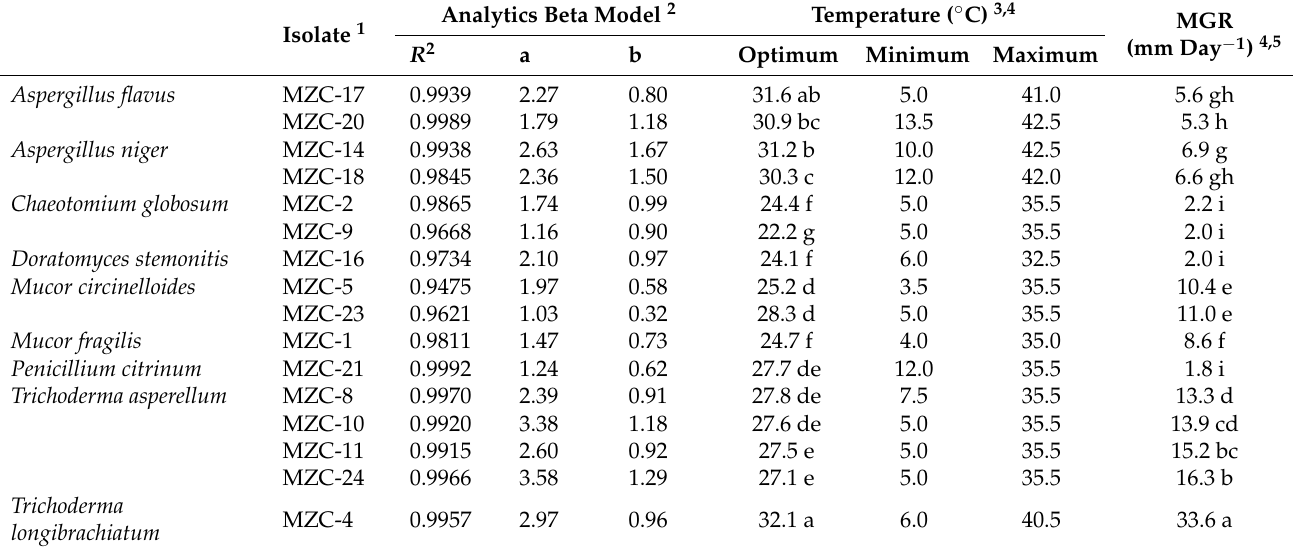
Table 5. Effect of temperature on mycelial growth of the fungal isolates included in this study 1 .